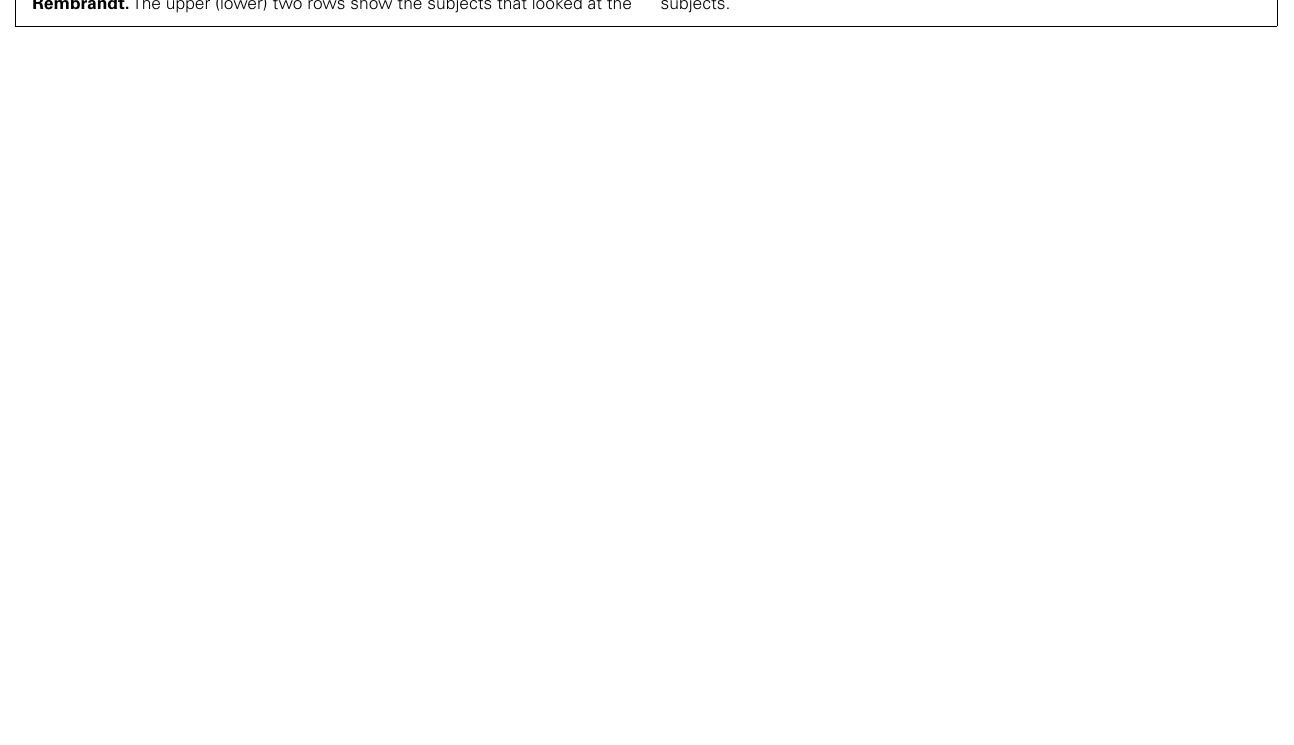
FIGUREA4 | Saccade patterns for all 10 subjects looking at the original and modified versions of “Philosopher in meditation” by Rembrandt. The upper (lower) two rows show the subjects that looked at the